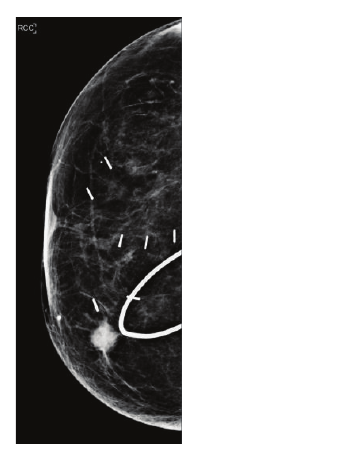
Figure 2: 2013 Mammogram. New highly suspicious breast mass at right 1:00 position.